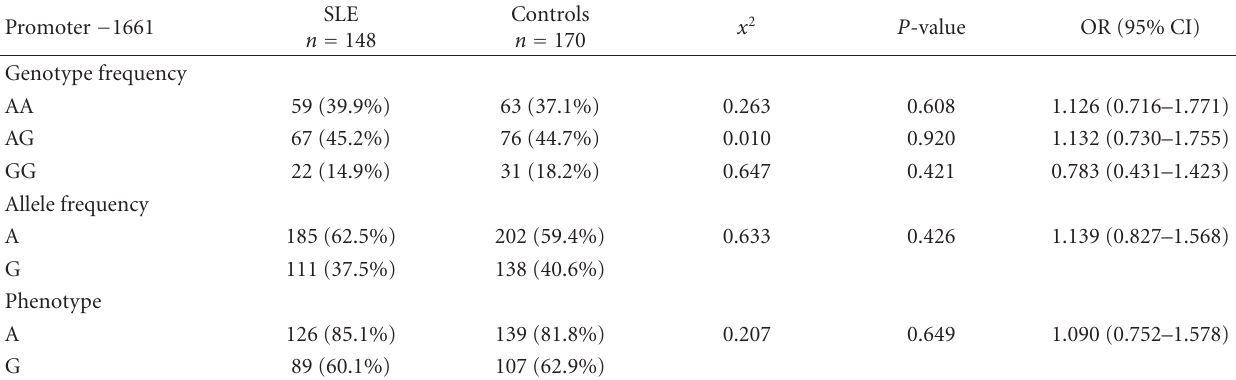
Table 2: Genotypic distribution and allelic frequencies of − 1661 CTLA-4 polymorphisms in Chinese SLE patients and healthy